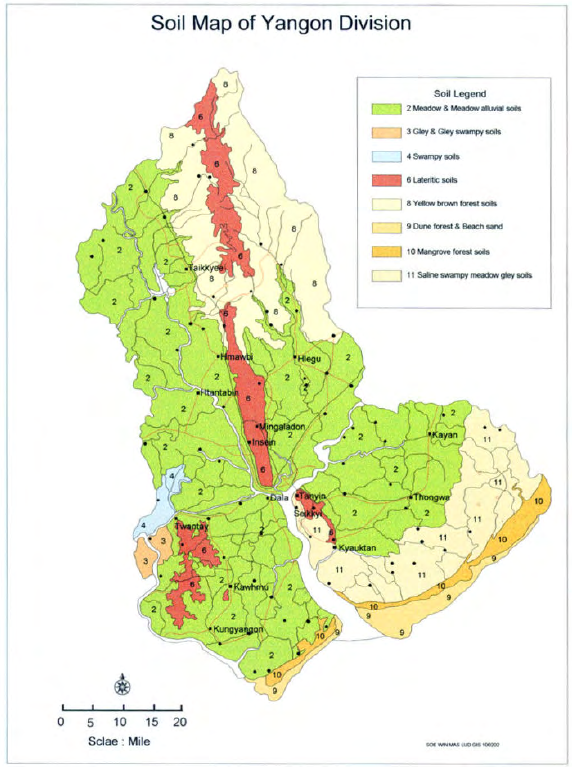
Figure 2. Soil map of the Yangon area (copyright of Land use division, Myanma Agriculture Service (Feb 11, 2002)